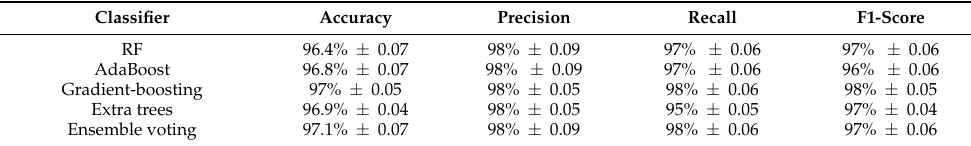
Table 4. Experimental results with tuned model hyperparameters with five-fold method.